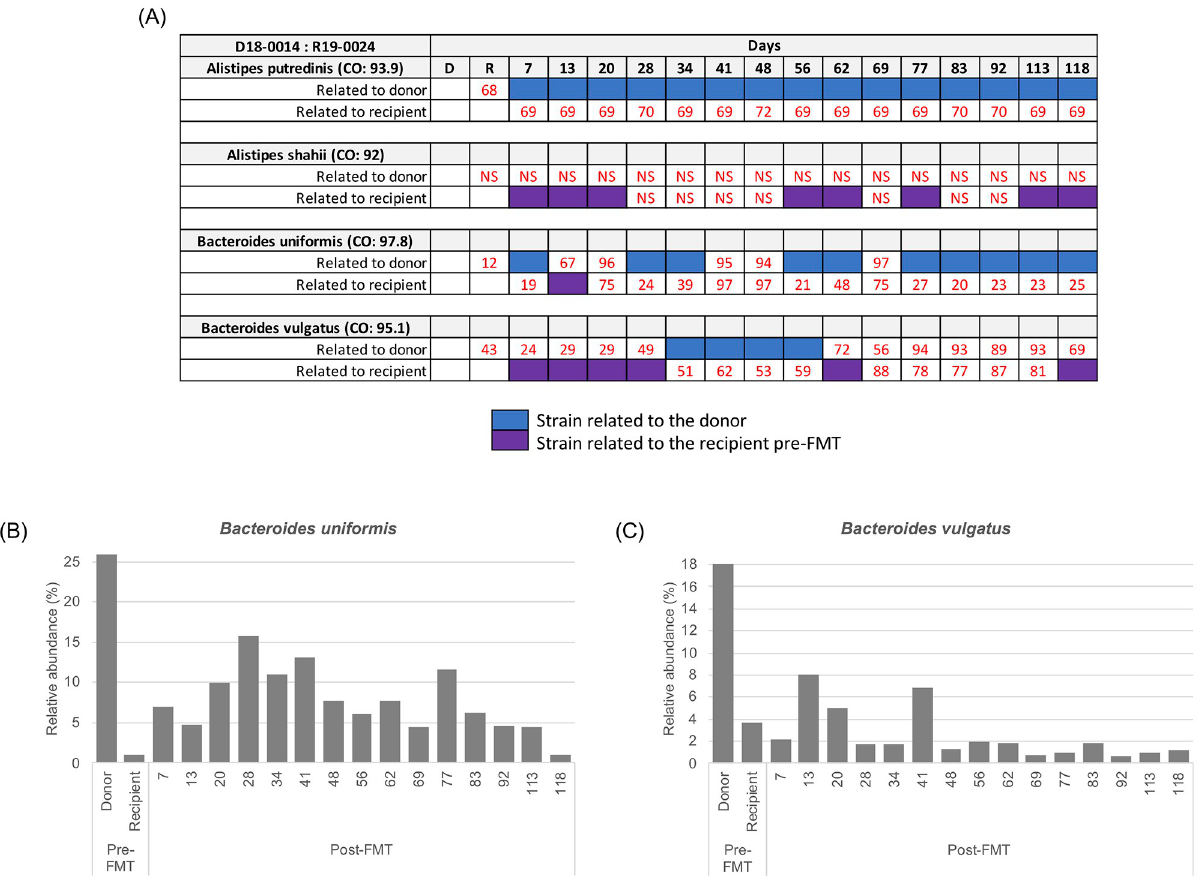
Fig 2. Summarized WSS scores with the taxonomic profile for the donor 18–0014 and recipient 19–0024 FMT pair. (A) The WSS scores were determined by comparing 1) the donor’s sample to paired recipient’s pre- and post-FMT samples; and 2) the recipient’s pre-FMT sample to the same recipient’s post-FMT samples for donor 18–0014 and recipient 19–0024. Detailed information for this pair of samples was shown in S1 Table. The summarized WSS result was grouped into different color boxes (see the figure key) or numerical numbers (when determined WSS score was below the cutoff value; NS = No Score). (B and C) Relative abundance was determined for Bacteroides uniformis and Bacteroides vulgatus for this pair using MetaPhlAn2